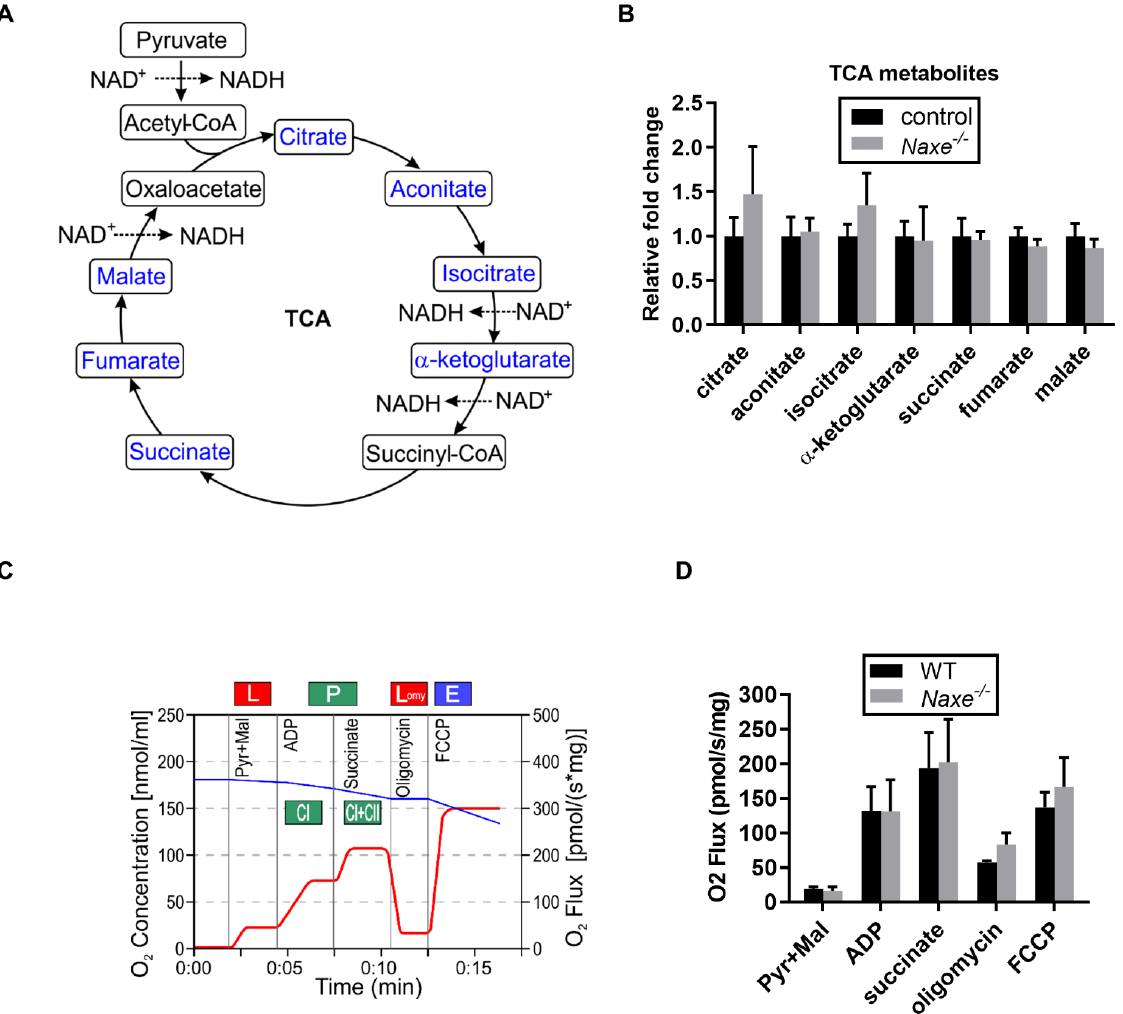
Figure 6. Effect of NAXE on mitochondrial function of murine cardiac tissue. ( A ) Scheme illustrating Krebs cycle in the mitochondria. ( B ) Relative abundance of tricarboxylic acid ( TCA ) metabolites. ( C ) Schematic diagram showing the protocol and analysis of key parameters of the Oroboros assay. L: leak, P: phosphorylation, Lomy: leak with oligomycin, E: electron transfer, CI: complex I phosphorylation, CI + CII: complex I and II phosphorylation. ( D ) Cardiac myofibers were harvested from P5 neonatal mice, single cell suspension prepared, and Oroboros assay performed to assess the role of NAXE in the mitochondrial function of murine cardiac tissues. The oxygen ( O 2 ) flux was normalized to the weight of the assayed cardiac tissues. Pyr + Mal: pyruvate – malate. Mean ± SE; n = 6 mice per group for B and n = 4 mice per group for D. Detected metabolites are indicated in blue. We then assessed free fatty acid content and found that C22 to C16 fatty acid levels